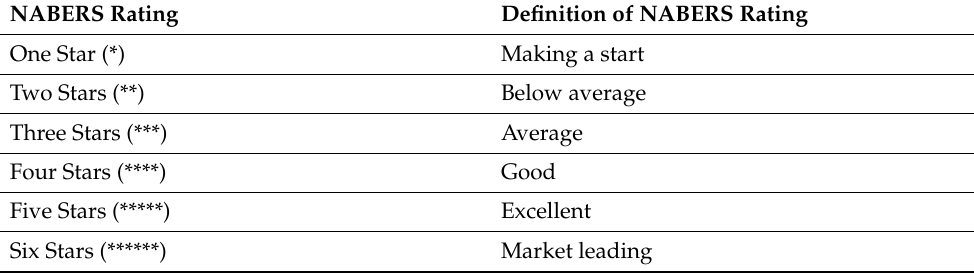
Table 1. Definition of NABERS